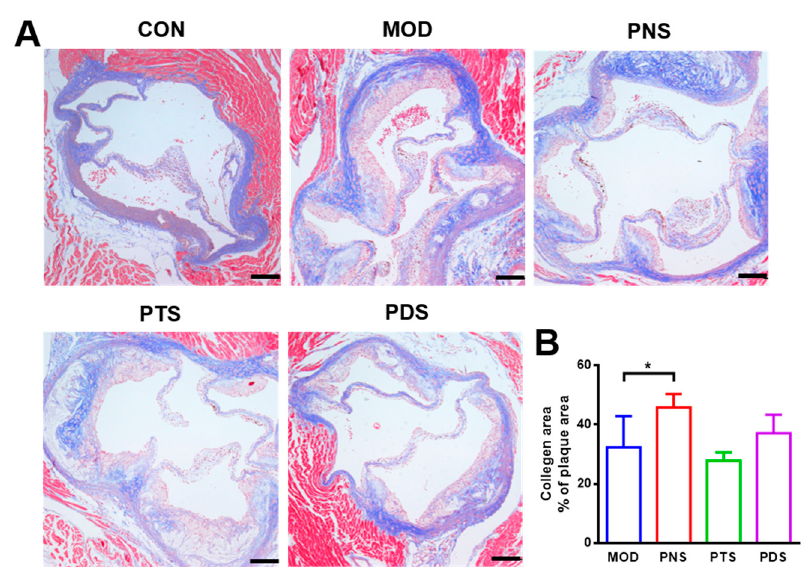
Figure 4. Representative of Masson’s trichrome staining sections ( A ) and the quantification of collagen areas to plaque areas ( B ). Scale bar, 200 µ m (n = 5–7). *, p < 0.05.